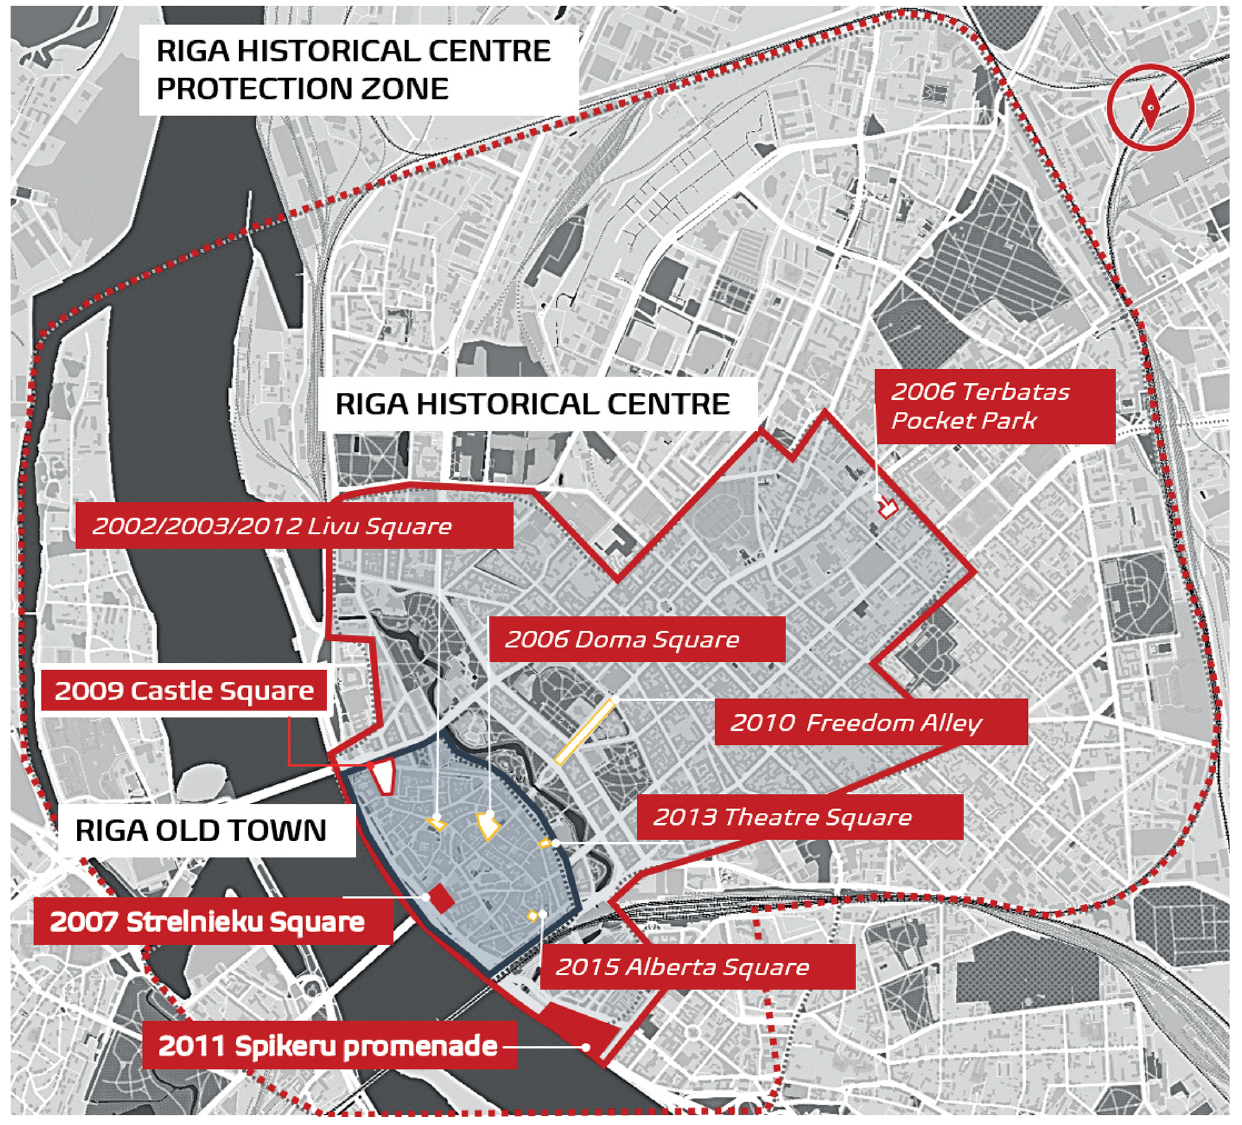
Figure 4. Competitions for public space in the RHC, organized between 1995 and